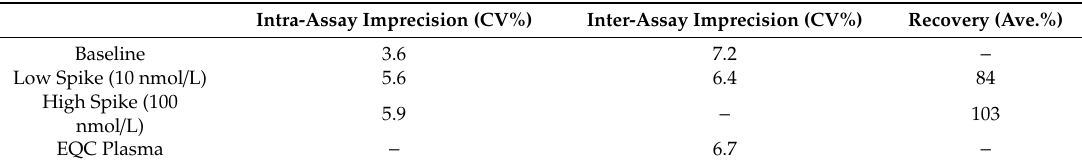
Table 2. Summary of the validation metrics for the LC-MS / MS CoQ 10